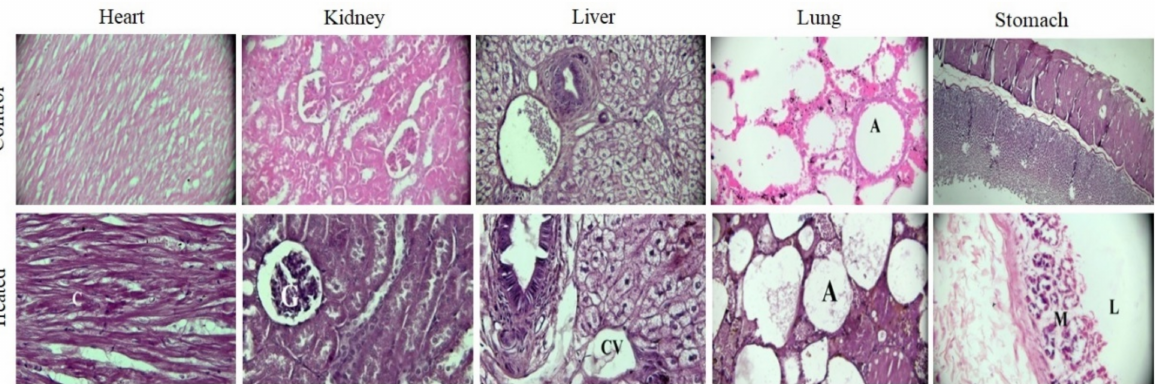
Figure 14. Histopathological images of control and treated animals. Accu-Scope 3001 microscope, fitted with 5-megapixel camera and 40 × lens was used to take images after eosin and hematoxylin stains. Cardiomyocytes of heart (C), glomerulus (G), central vein (CV), alveolar sacs (A), lumen (L), and mucosa